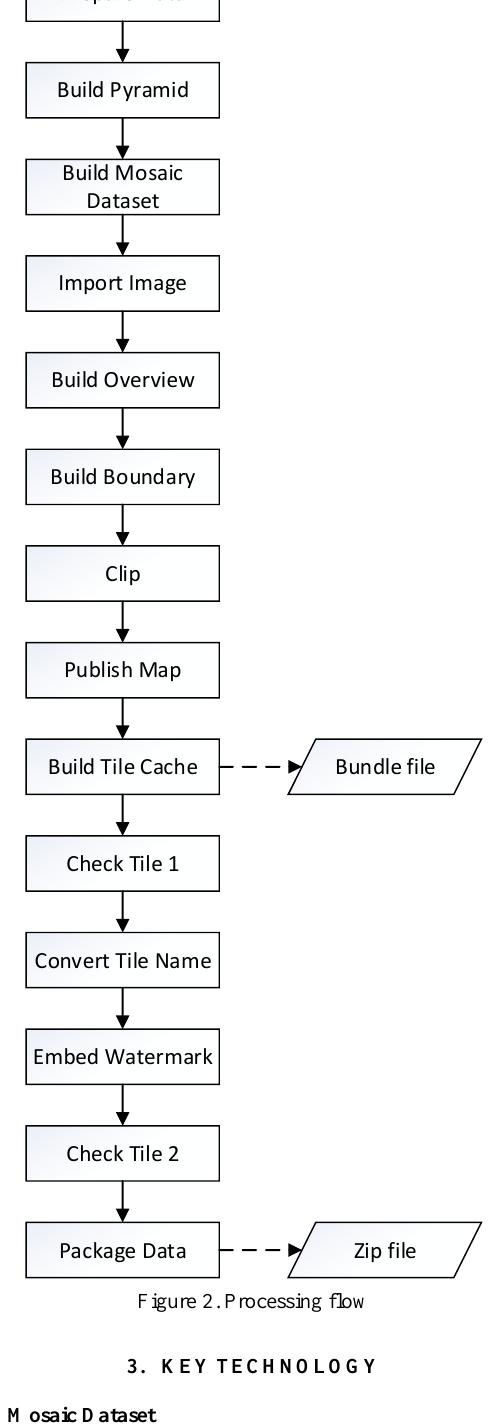
Figure 2. Processing